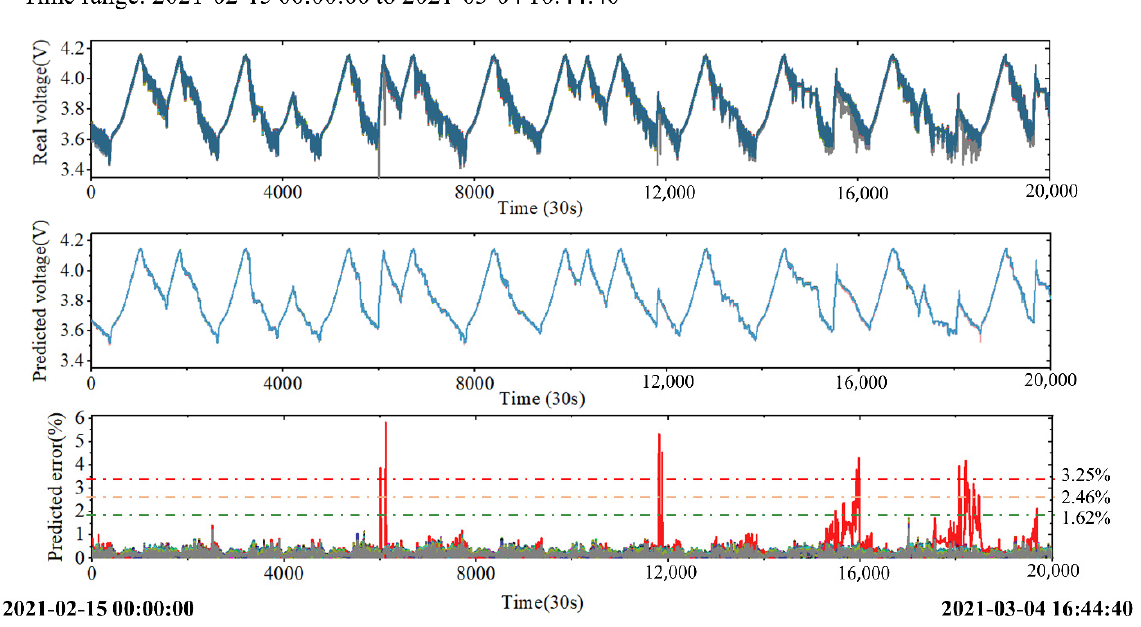
Figure 8. Battery voltage prediction results for no. 4 vehicle before corrective maintenance.